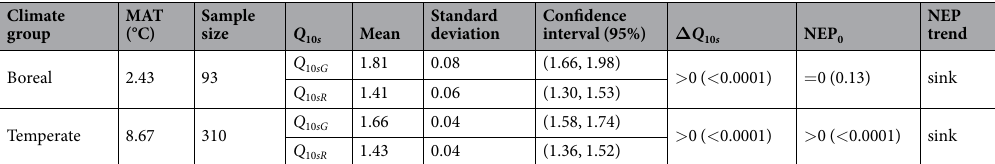
Table 1. Basic information, temperature sensitivity indexes of assimilation rate (GPP, Q 10 sG ) and respiration rate (RE,